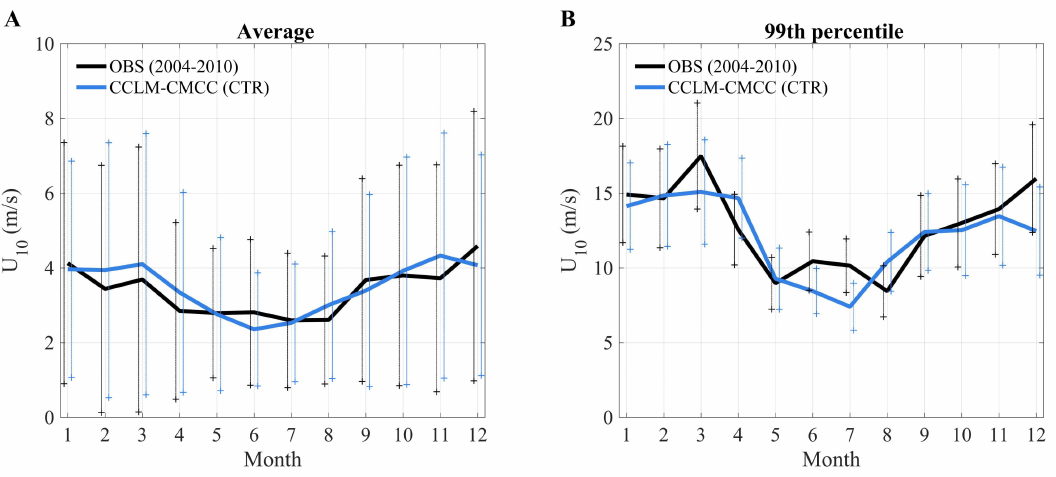
Figure 4. Performance of ERA5 horizontal wind speed and direction. Comparison with in situ observations (OBS) in the northern Adriatic Sea (Acqua Alta oceanographic platform, AA) during years 2004–2010 (total entries: 60,331). ( A ) Scatter diagram (color shade, linear scale) and quantile- quantile plot (Q-Q, red markers) of U 10 (in m/s) at 1%-interval up to 99th and 0.1% interval above. Mean error ( ME ), mean absolute error ( MAE ), and slope ( Slope ) of the line of best fit (thick black) are shown in the plot area. The dashed black line indicates the perfect 1:1 match between datasets. ( B ) Relative frequency histogram of wind direction of flow from OBS (black line) and ERA5 (red line). The directional sectors of Bora and Sirocco are labeled.